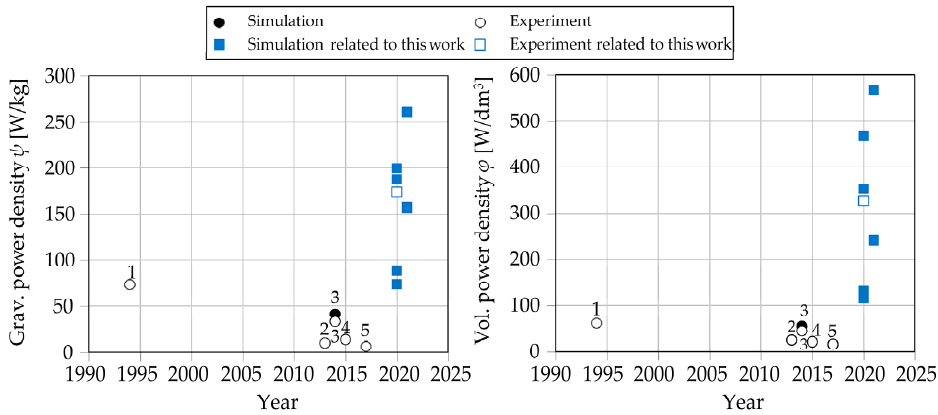
Figure 14. Comparison of gravimetric (left) and volumetric (right) power density of TEG systems for HDV applications (data from: 1: [8] 2: [22], 3: [23,24], 4: [10], 5: [12]). The power densities of the functional model specified and measured in Section